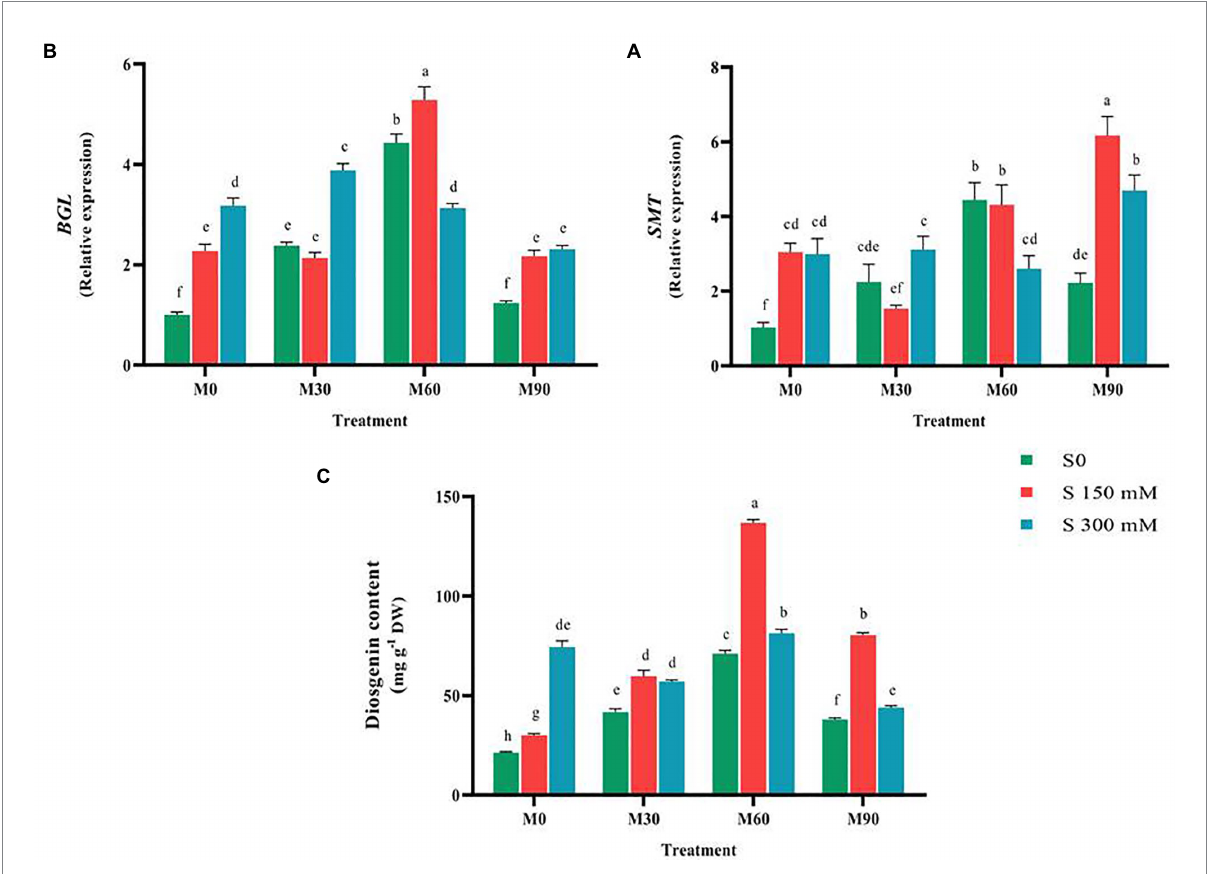
FIGURE 6 The mean comparison effects of melatonin concentrations and different levels of NaCl on the expression of (A) SMT , (B) BGL , and (C) Diosgenin content. Duncan method at 1% probability level was applied to compare mean values. The columns having similar letters had no significant